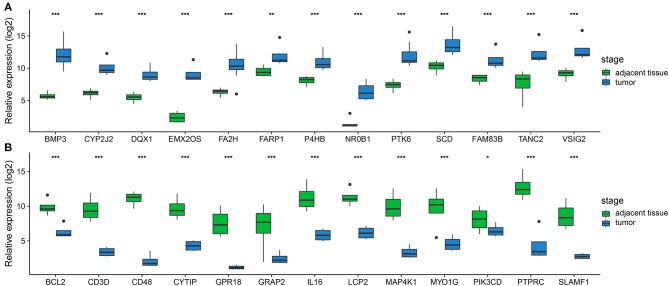
Validation of DEGs by qRT-PCR. (A,B) Boxplots indicate the medians and dispersions of 24 bladder cancer and their adjacent tissue samples. P-values are counted by student's t-test, *p < 0.05, **p < 0.01, ***p < 0.001.